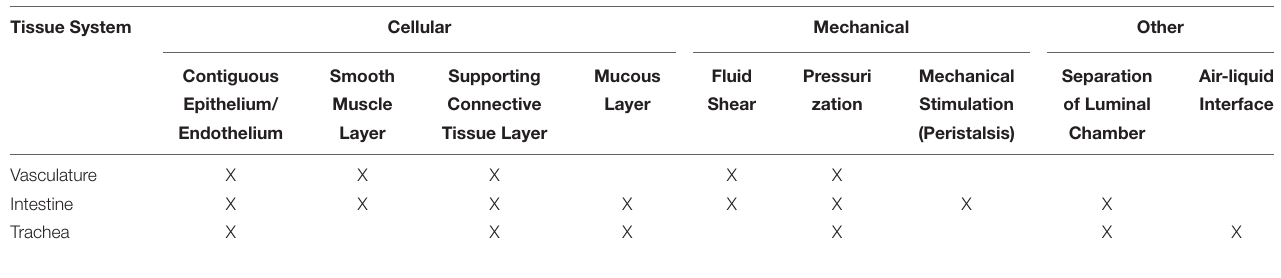
TABLE 1 | Design criteria for tubular tissue engineered scaffold development as a function of tissue type. Tissue